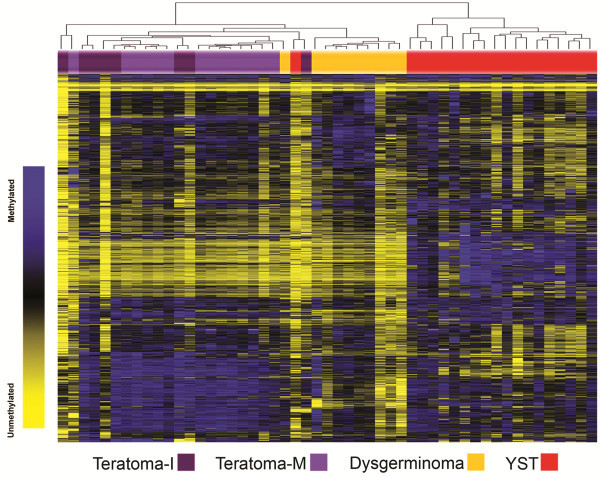
Unsupervised hierarchical clustering of CpG methylation in GCTs by tumor histology. Heat map from unsupervised hierarchical clustering based on Manhattan distance and average linkage of the 1404 autosomal CpG loci that passed initial quality control checks. Colored bars represent histologic subtype of the tumor. Light purple represents mature teratoma, dark purple represents immature teratoma, orange represents germinoma and red represents yolk sac tumor. Samples are in columns (N = 51) and CpG loci are in rows. Blue indicates high level of methylation (51-100%), black equals 50% methylation, and yellow indicates low level of methylation (0-49%).